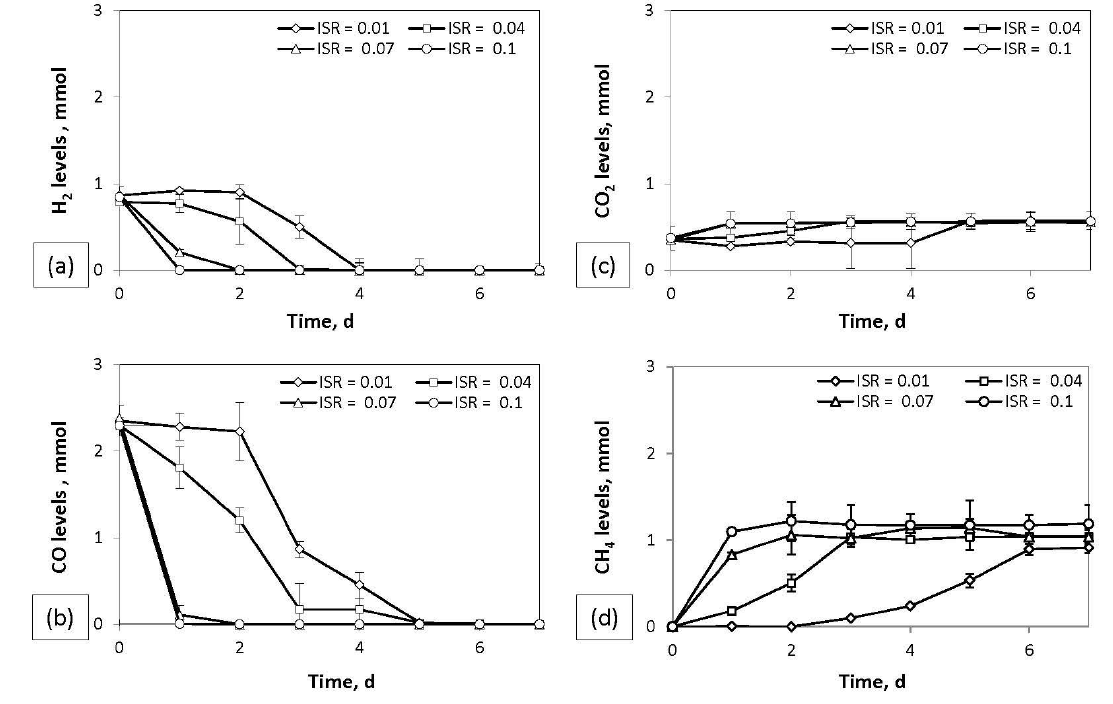
Figure 6. Syngas biomethanation in batch bioreactors with an ISR of 0.01, 0.04, 0.07, and 0.1 (g/mL). Consumption of ( a ) H 2 and ( b ) CO and production of ( c ) CO 2 and ( d ) CH 4 in mmol.